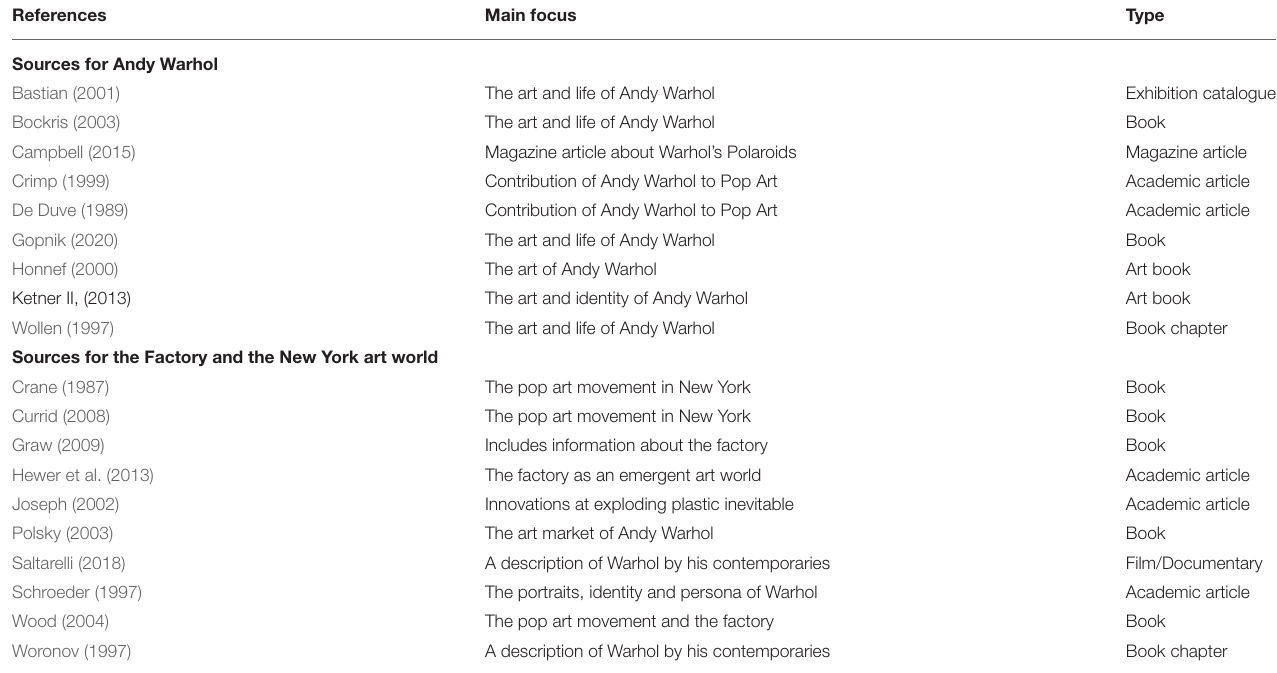
TABLE 1 | The sources of secondary data used in the case study of Andy